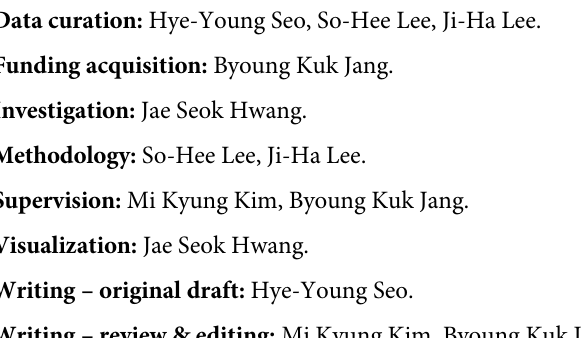
(C) Western blot analyses showing the effect of kahweol on LC3, ATG5, ATG7, and Beclin1 expression in AML12 cells (left) and primary hepatocytes (right). (TIF) S1 Raw